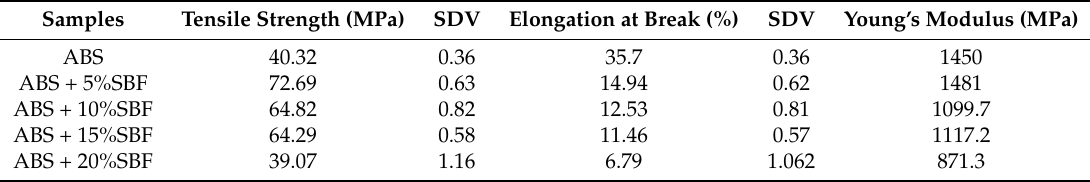
Table 3. Tensile test results.